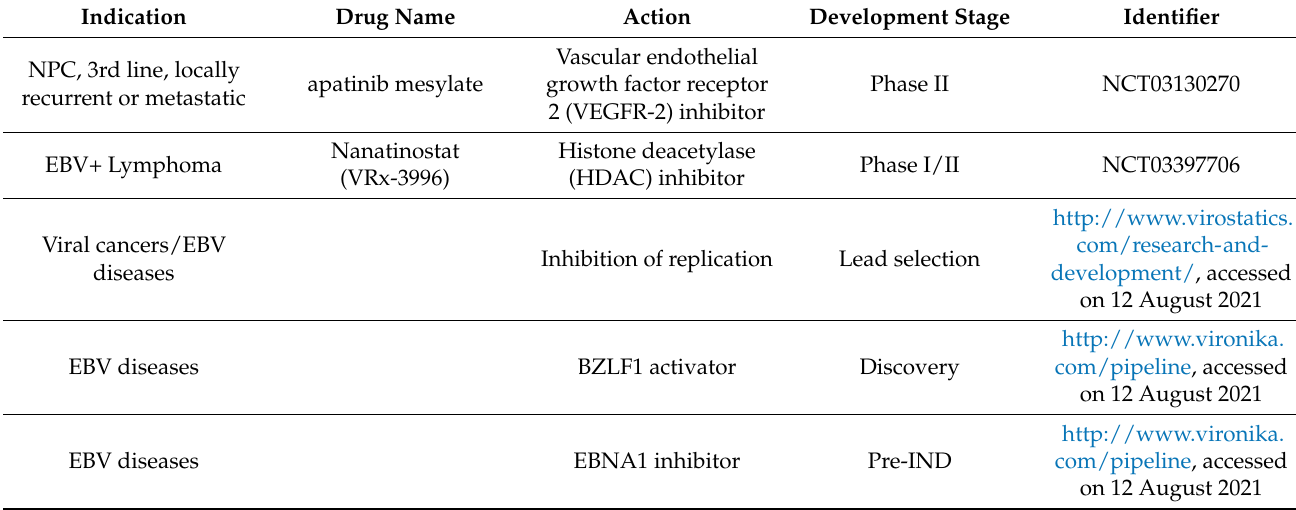
Table 6. Small molecule pipeline for EBV-linked malignancies.